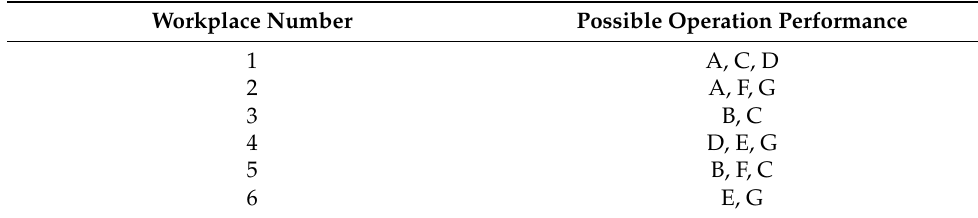
Table 2. The interchangeability of